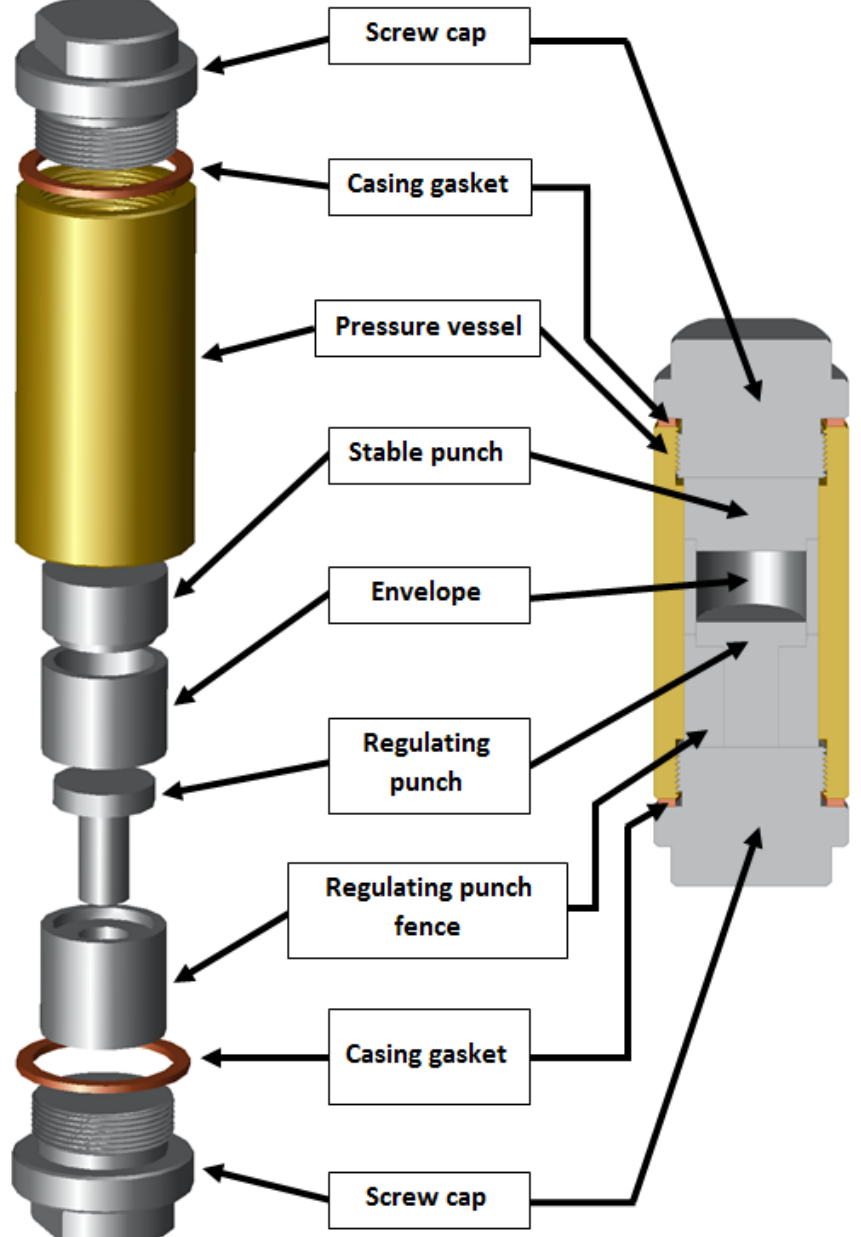
Figure 1. Scheme of the experimental reactor used in